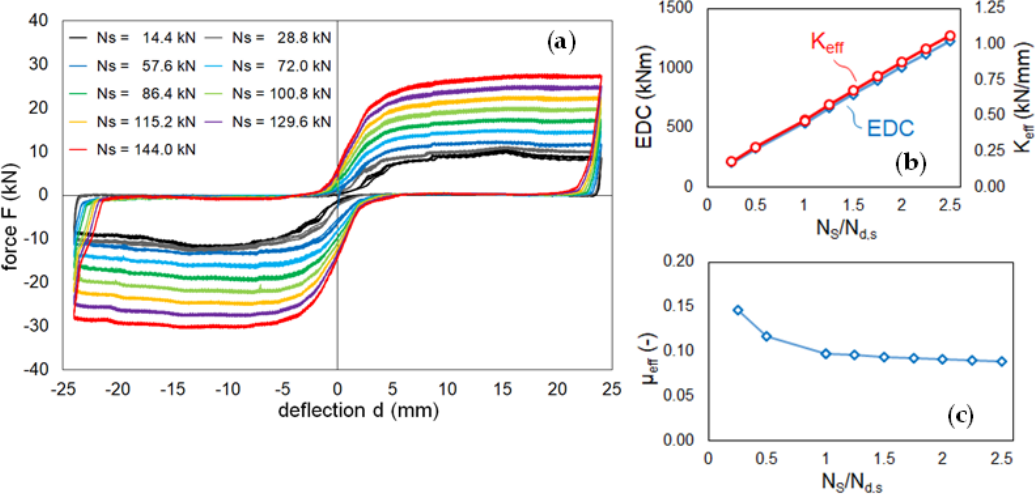
Figure 10. Static test (S): ( a ) horizontal force–deflection diagrams at different levels of vertical load N S ; ( b ) influence of the vertical load on effective Stiffness K eff , energy dissipated per cycle EDC; ( c ) effective coefficient of friction μ eff . N d,s is the design vertical load of the prototype.